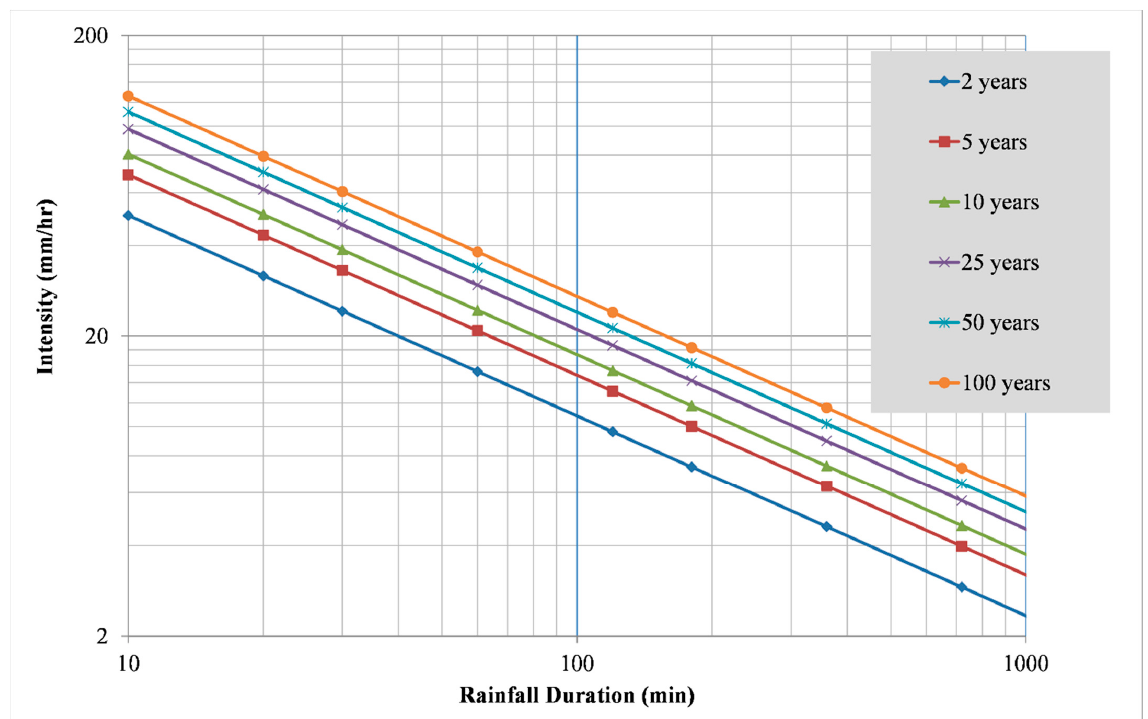
Figure 6. IDF curves generated using the LPT III method on an ordinary scale.